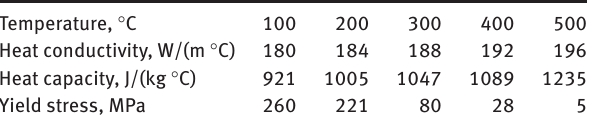
Table 1: Physical property of the 6063-T6 aluminum.